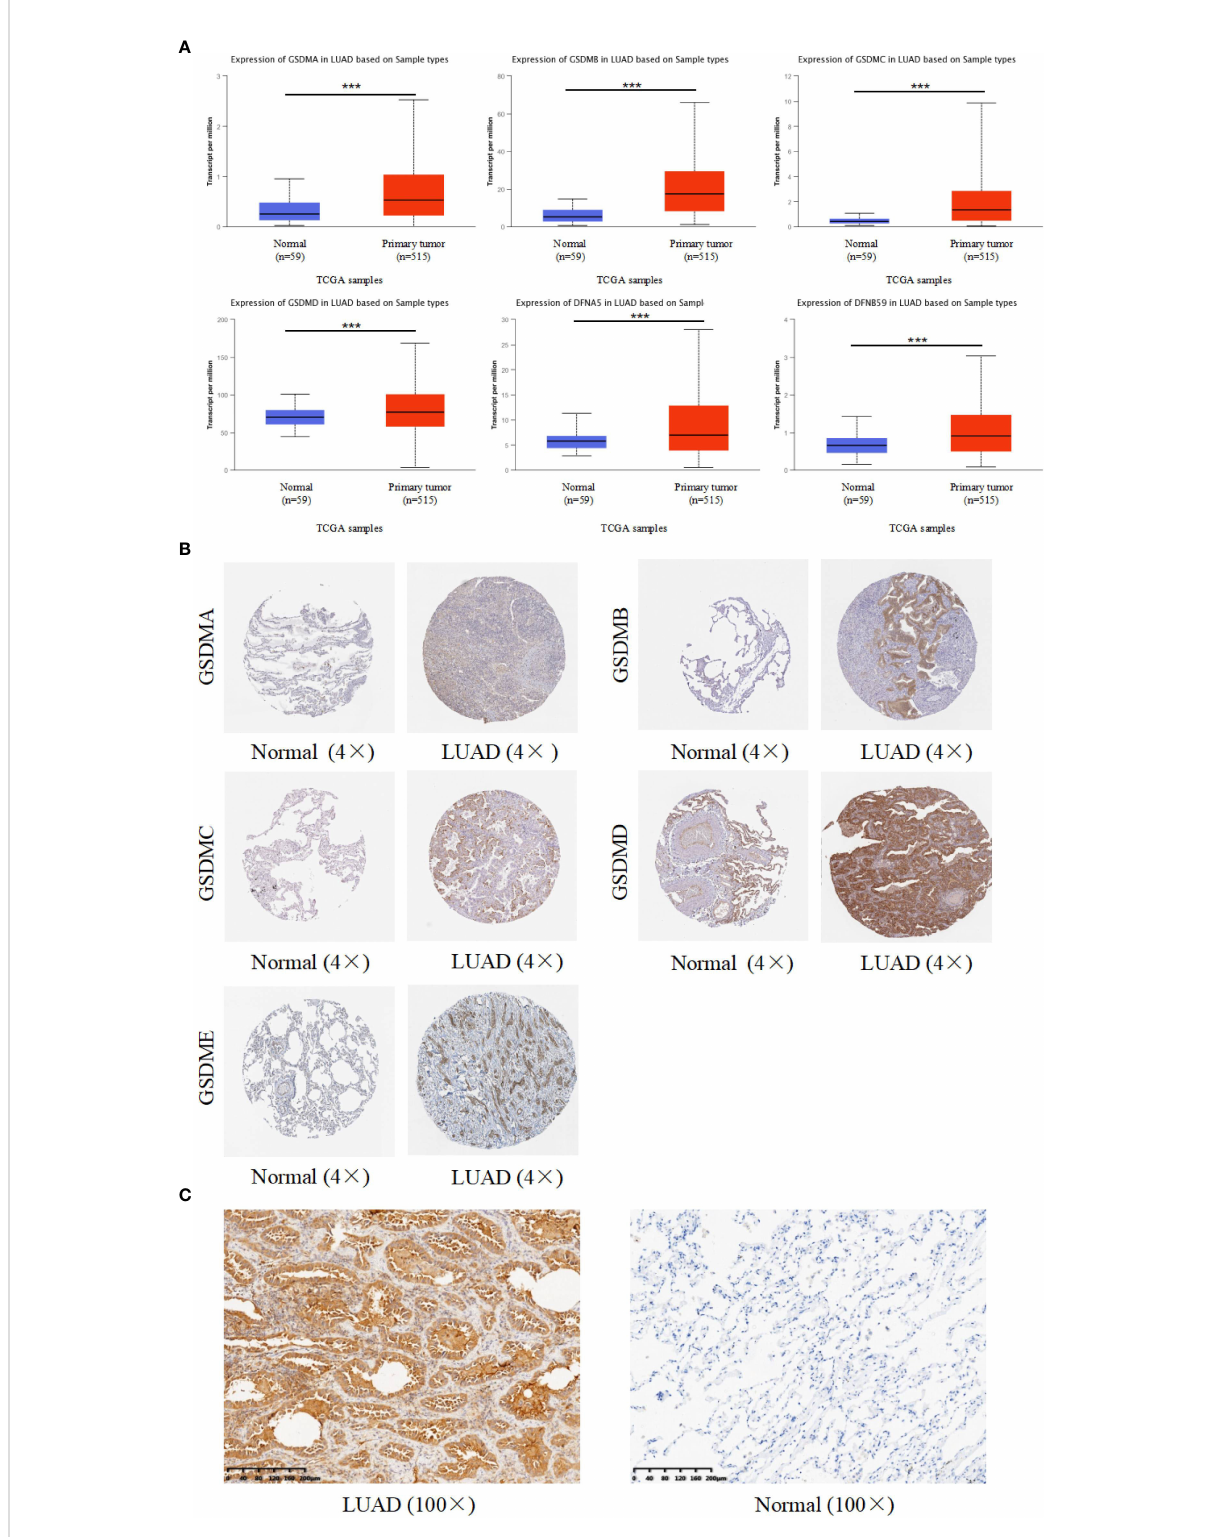
FIGURE 2 Expression of six GSDM family members in LUAD. (A) The UALCAN database was used to retrieve the GSDMs ’ mRNA expression pro fi les. (B) The THPA database was used to collect IHC images of GSDM family members from LUAD tissues and normal lung tissues, representing the GSDM protein expression levels. (C) The IHC result of GSDMD expression in LAUD and adjacent normal lung tissue. *** means